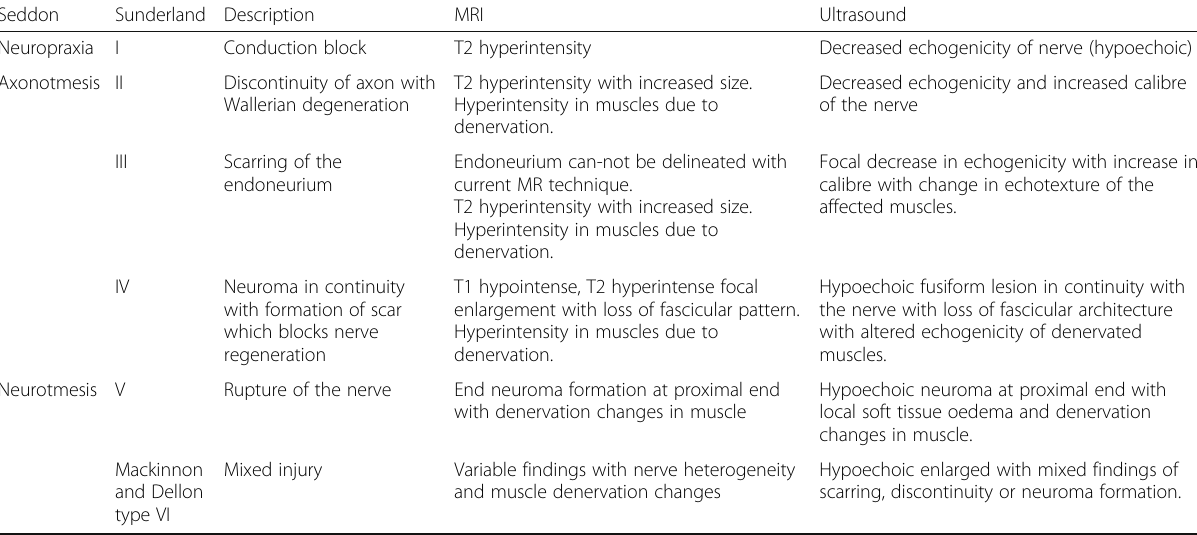
Table 1 Classification of nerve injury according to Seddon and Sunderland with corresponding findings on HRUS and MRI [10]